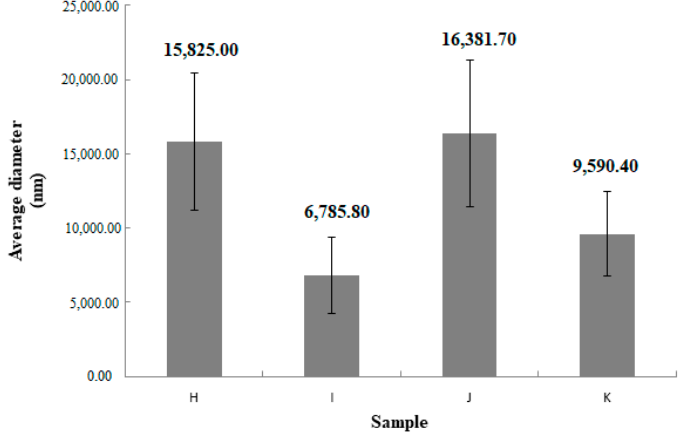
Figure 2. Obtained results for measurements of hydrodynamic diameter of liposome particles, n = 5, the Y-bars represent the standard deviation.